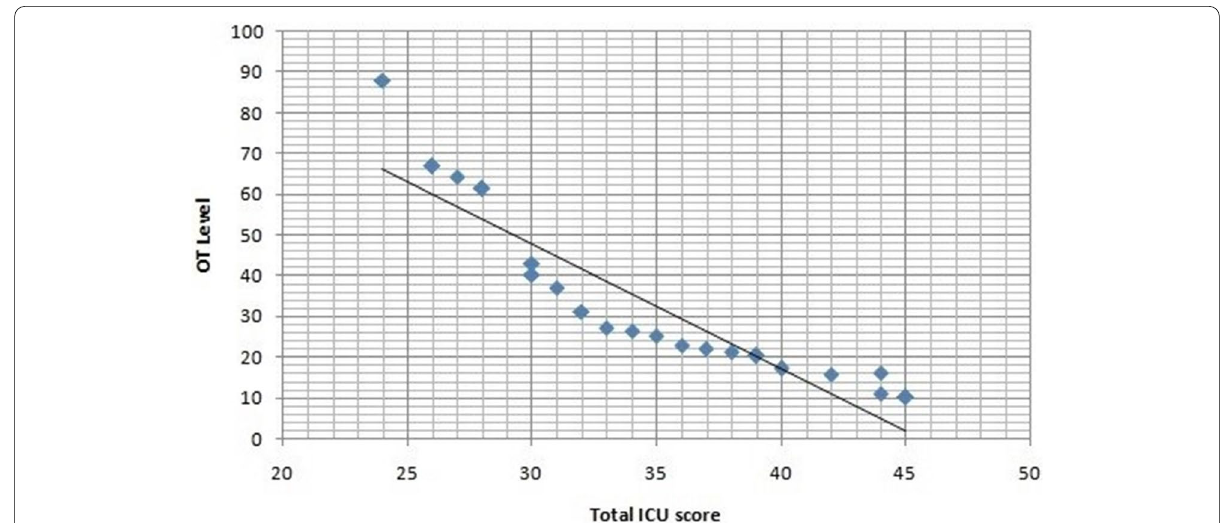
Fig. 2 Correlation between oxytocin levels and the total score of the Inventory of Callous-Unemotional Traits (ICU—self -